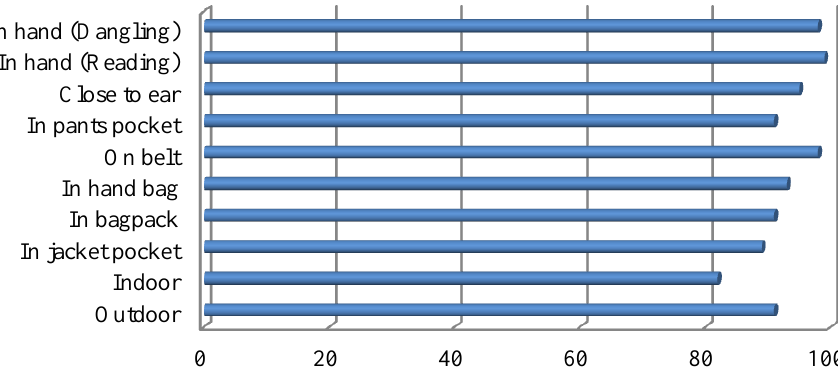
Figure 9. Recognition rates for different device positions using FIS algorithm.